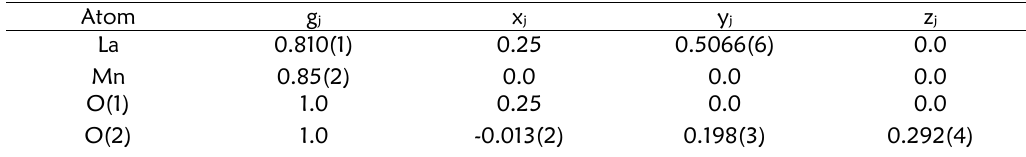
Table 1. The coordinates of atomic fractions (x j , y j , z j ), and atomic occupancy factor (g j ) of S0